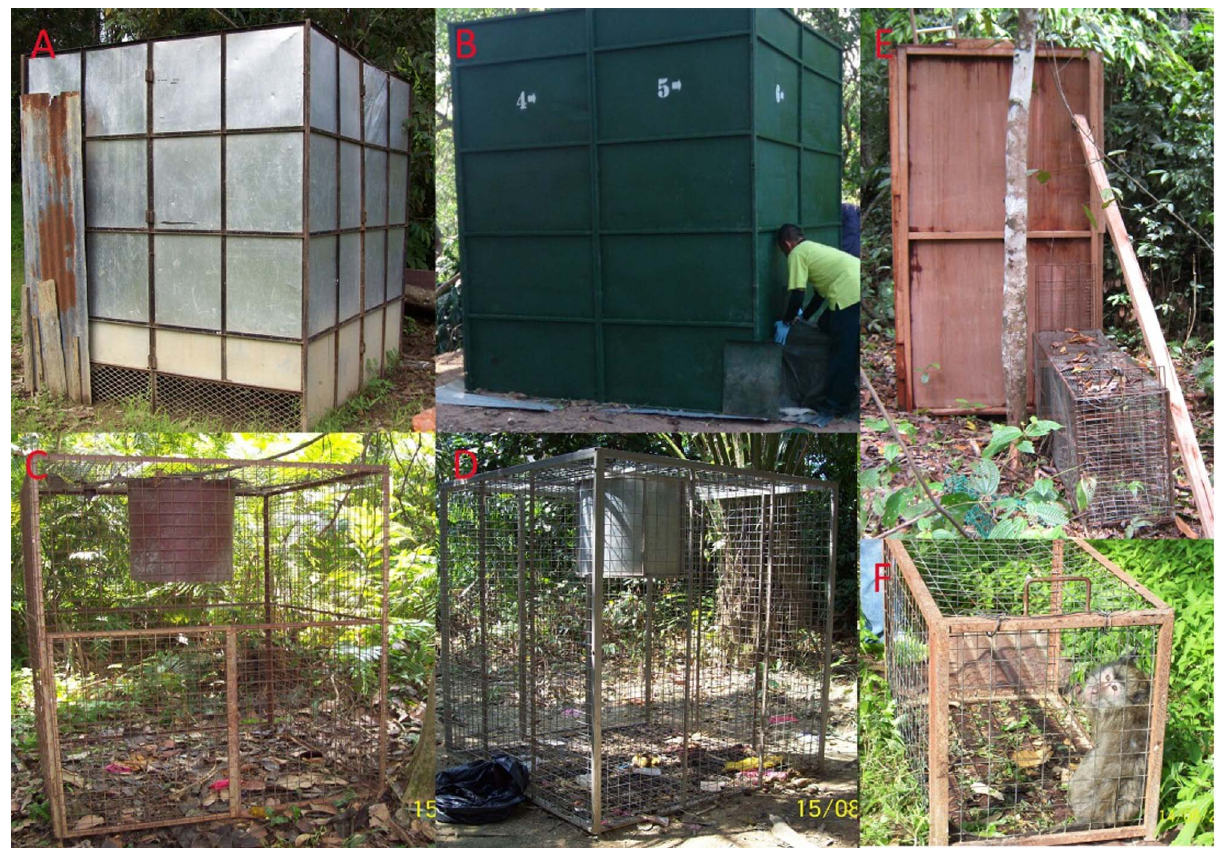
Figure 2. Types of monkey traps used in this